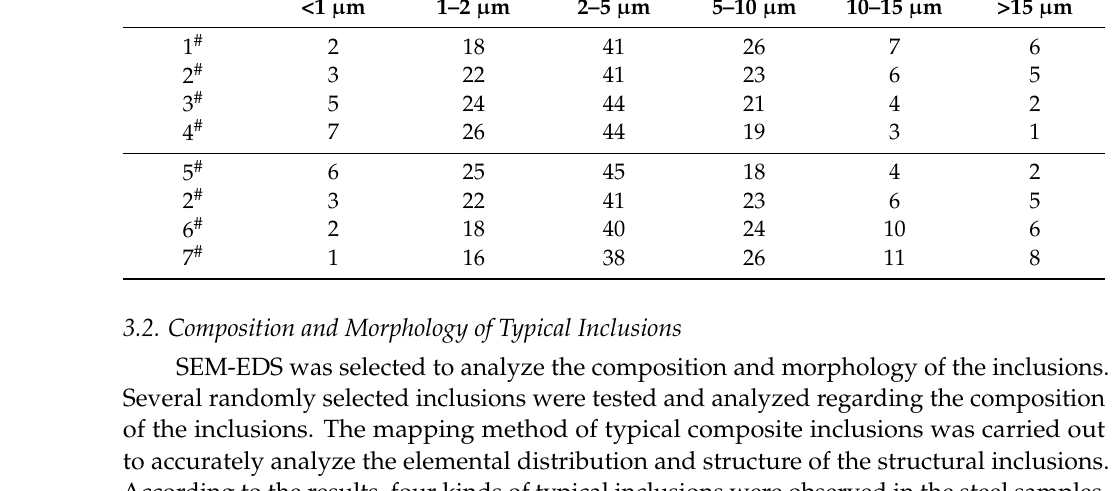
Table 5. The size distribution of the inclusions in the 1 # ~7 # steel samples (percentage). <1 μ m